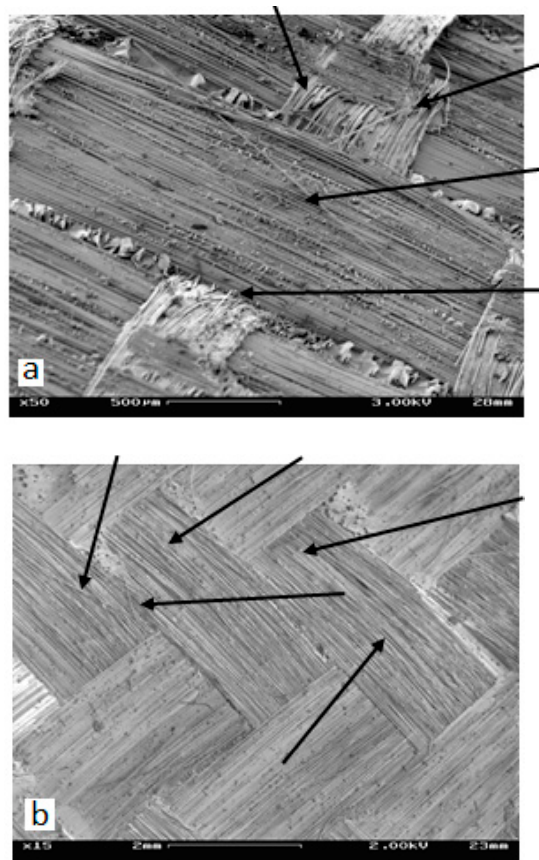
Figure 18. A small number of broken fibers (pointed out by arrows) were located at the strand periphery, indicating that the delamination roughly followed the strands envelope and did not penetrate the strands: ( a ) Laminate A, ( b ) Laminate B.